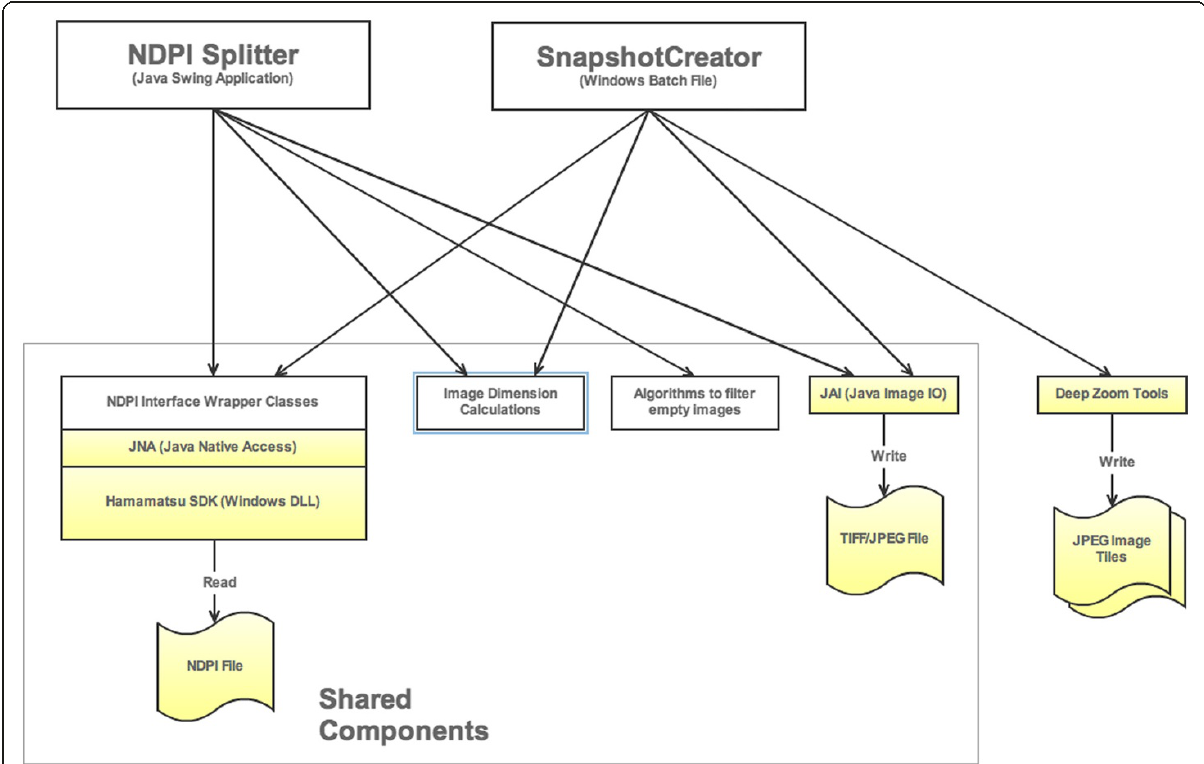
Figure 1 Software architecture overview: Both NDPI Splitter and Snapshot Creator use the same underlying classes to interact with the proprietary NDPI file format using Hamamatsu